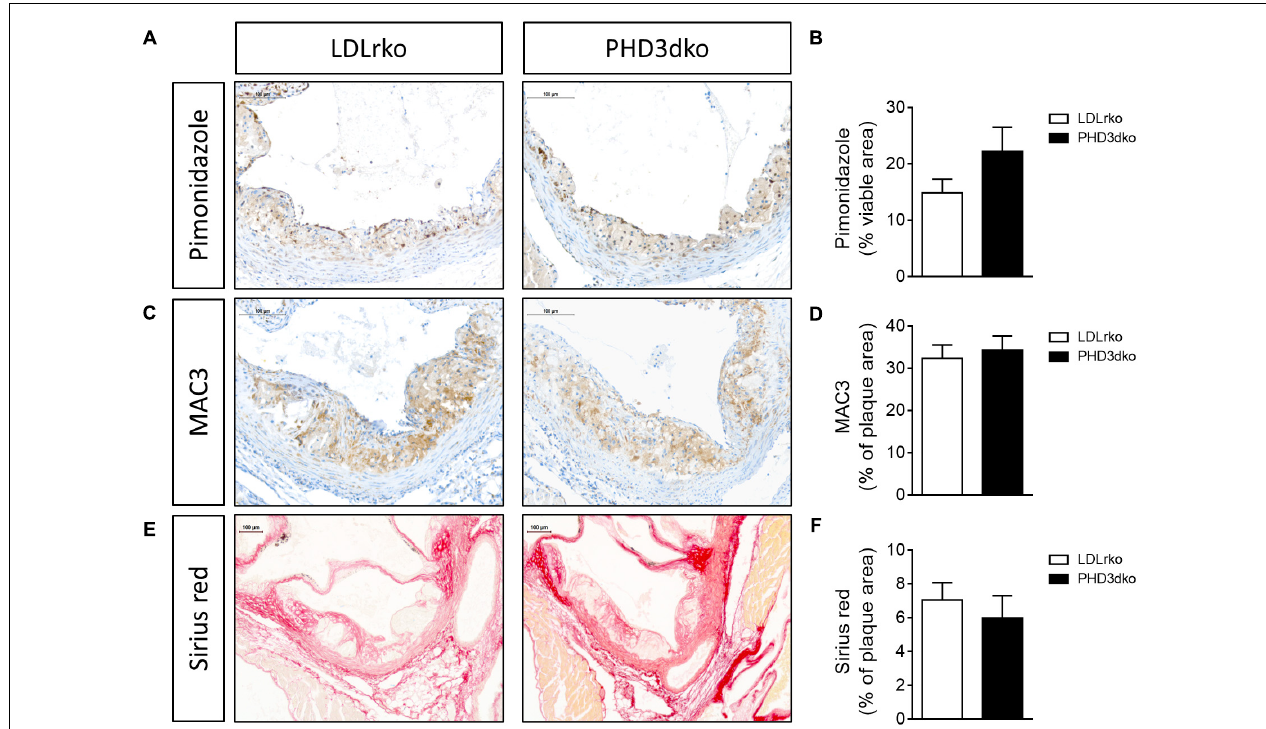
FIGURE 4 | PHD3dko did not affect plaque hypoxia, macrophage or collagen content. (A) Representative microphotographs of aortic root sections stained for hypoxia content (pimonidazole), (B) quantification (PHD3dko n = 18, LDLrko n = 10), (C) macrophage content (MAC3), and (D) quantification (PHD3dko n = 16, LDLrko n = 10), (E) collagen content (Picro sirius red), and (F) quantification (PHD3dko n = 18, LDLrko n = 11). Scalebar represents 100 µ